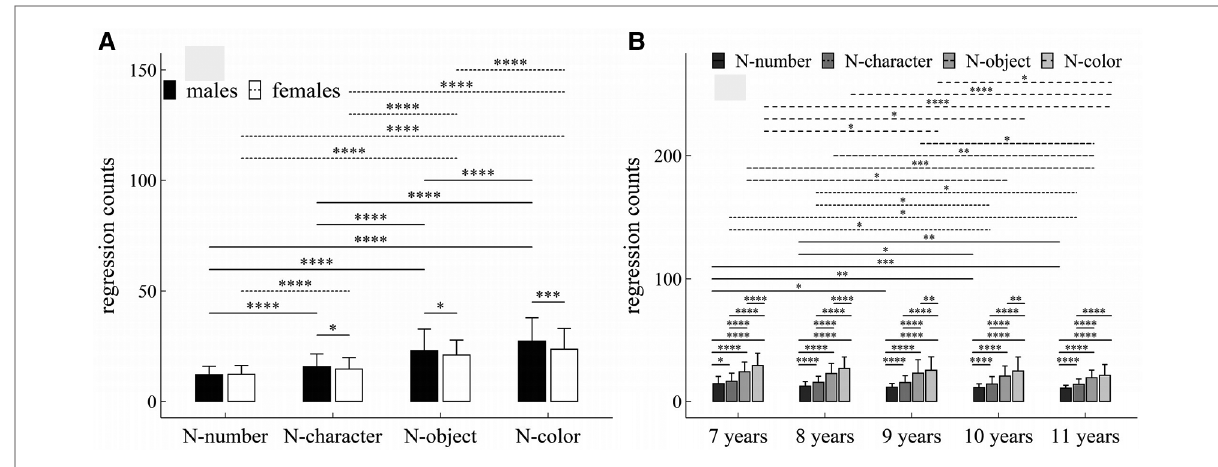
FIGURE 3 In fl uence of task-type, gender and age on regression counts: ( A ) interactive effect of gender and task-type; ( B ) interactive effect of age and task-type. * p <0.05; ** p <0.01; *** p <0.001; **** p <1×10 − 4 .